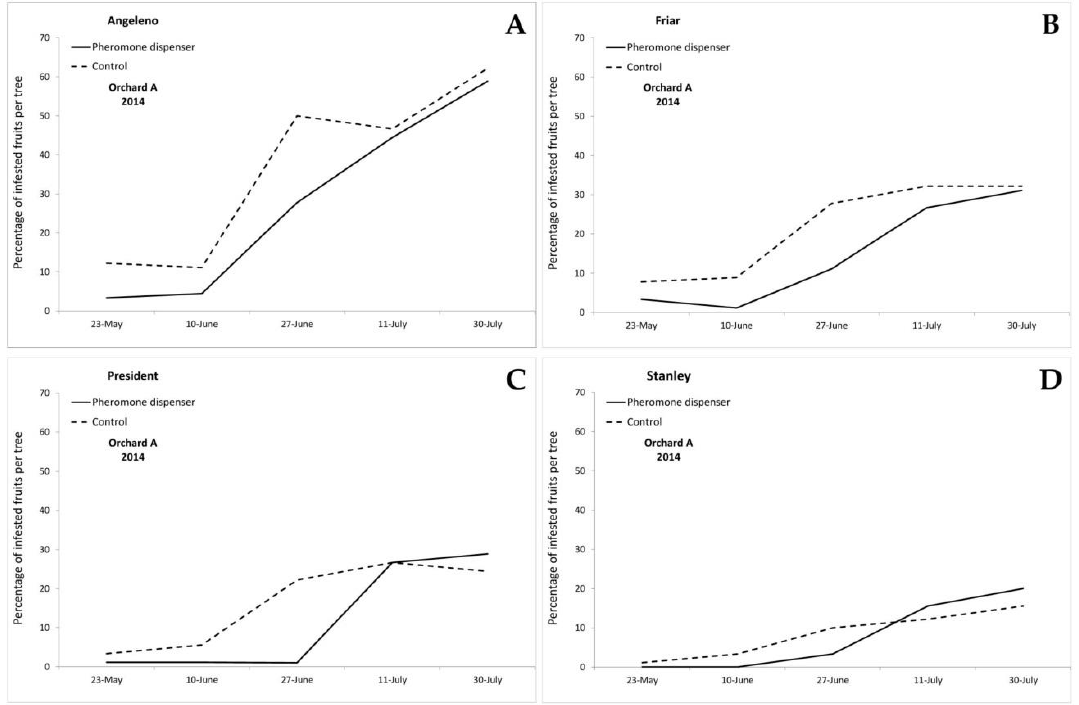
Figure 3. Infestation trend (mean percentage of infested fruits per tree) recorded in 2014 in Orchard A in the cultivars ( A ) Angeleno, ( B ) Friar, ( C ) President, and ( D ) Stanley.